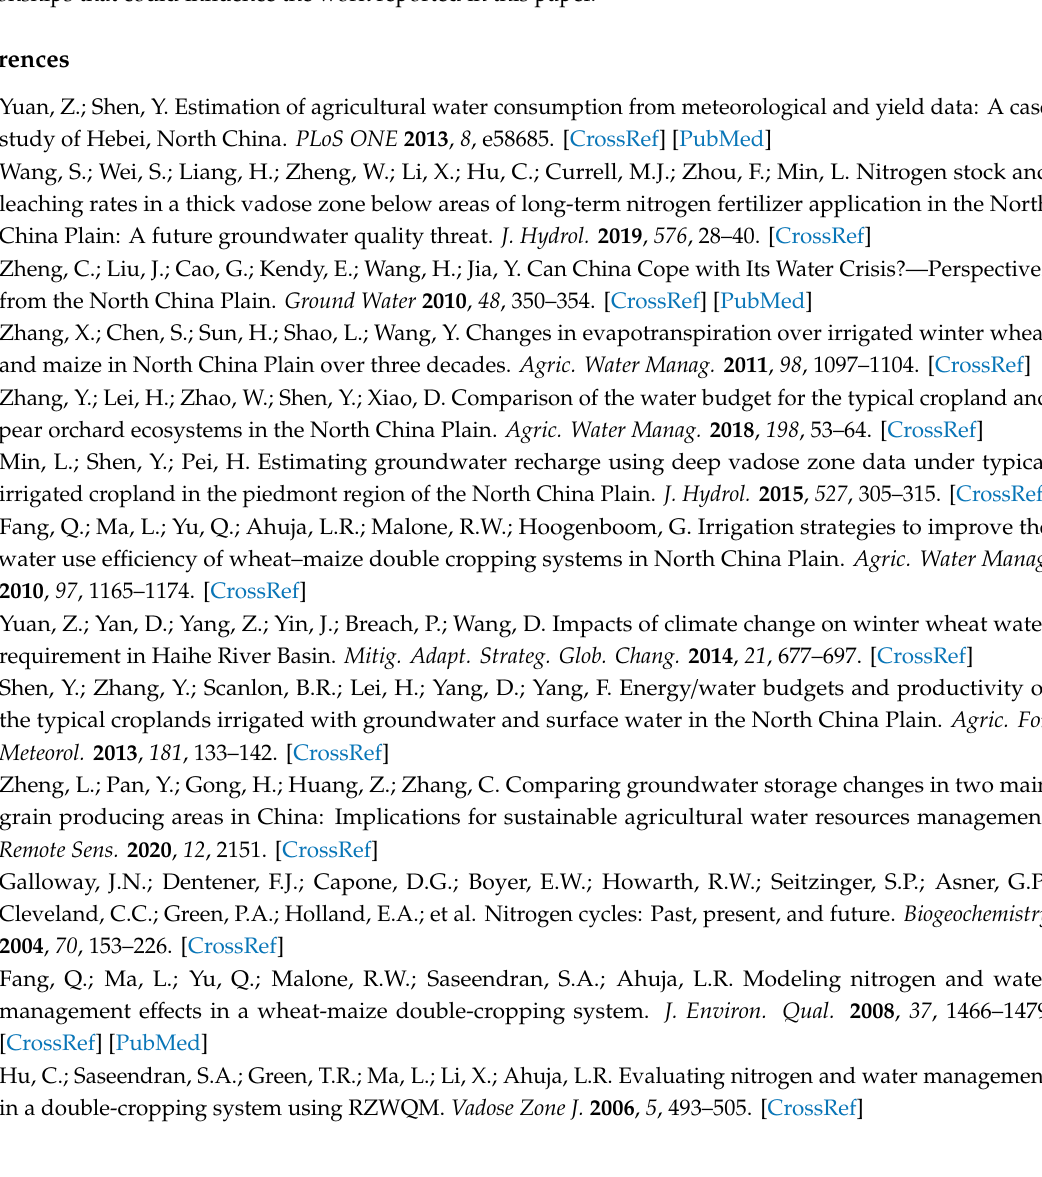
Figure S1: A map showing the location of the North China Plain (NCP) in China (inset plate on the left) and the Luancheng Agro-Ecological Experimental Station (LAES) (main plate on the left) in the plain, Figure S2: Comparisons of observed and simulated soil nitrate content by the RZWQM2 model for calibration (a) and validation (b) in the 0-180 cm soil profile, Table S1: The RMSEs and MREs between the observed and simulated soil water content in di ff erent soil layers and soil water storage (SWS) in the total profile by the RZWQM2 model, Table S2: The RMSEs and MREs between the observed and simulated soil nitrate-nitrogen content (SNC) in di ff erent soil layers and soil nitrate -nitrogen storage (SNS) in the total profile by the RZWQM2 model, Table S3: The RMSEs and MREs between the observed and simulated leaf area index (LAI), yield and biomass of winter wheat and summer maize by the RZWQM2 model, and the results of the calibrated model parameters of the RZWQM2